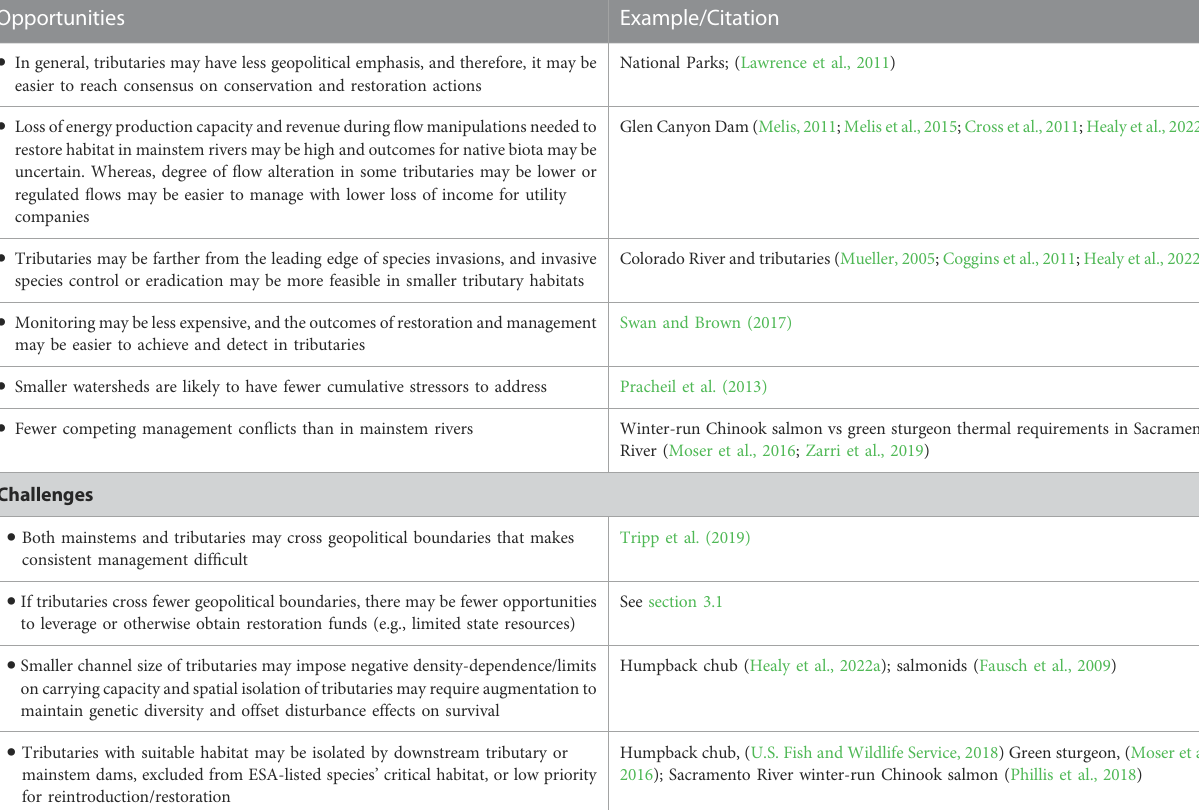
TABLE 1 List of opportunities and challenges to including tributaries in conservation and management of large rivers.